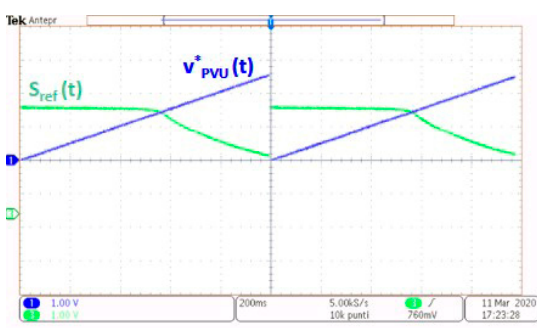
Figure 12. Oscilloscope screenshot ( S = 400 W / m 2 , T = 57.5 ◦ C, and V dsmax = 50 V).